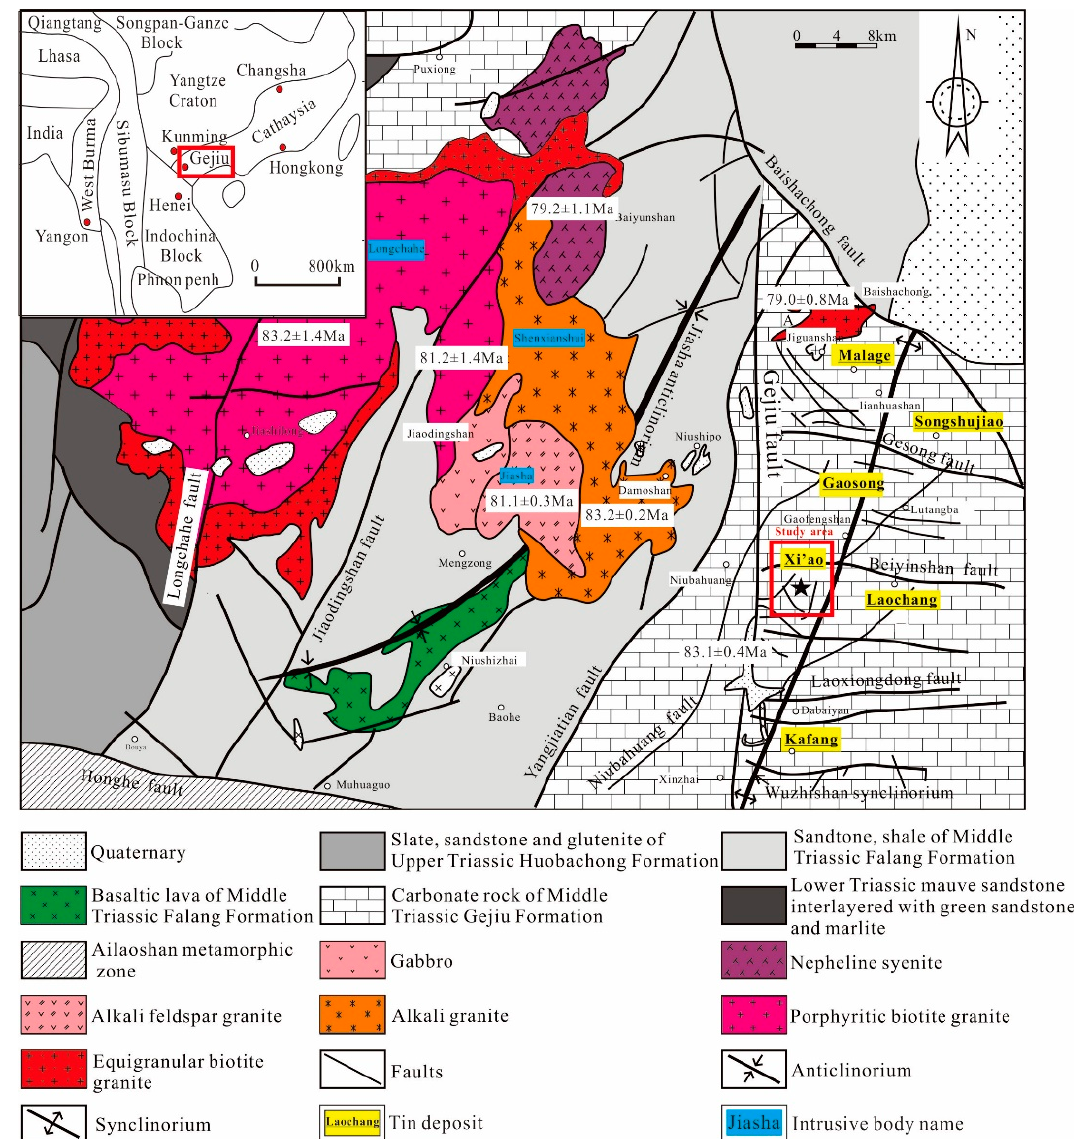
Figure 1. Geotectonic location (after [39]) and geological sketch map of Gejiu area, Yunnan Province (modified after [40]). The star shows the location of the Xi’ao Cu-Sn polymetallic deposit. Frequent multistage magmatic activity occurred in the Gejiu area. Gejiu magmatic intrusions (emplacement ages are marked in Figure 1), which show a large variability, including gabbro, nepheline syenite, alkali feldspar granite, alkali granite, porphyritic biotite granite, and granular biotite granite, are widely exposed in the western area of Geiju but are sparsely distributed in the eastern area. The ages of granites in Gejiu range from 53 Ma to 147 Ma according to dating obtained by different methods such as Ar-Ar/K-Ar, Rb-Sr, LA-ICP-MS/TIMS/SHRIMP (Sensitive High-